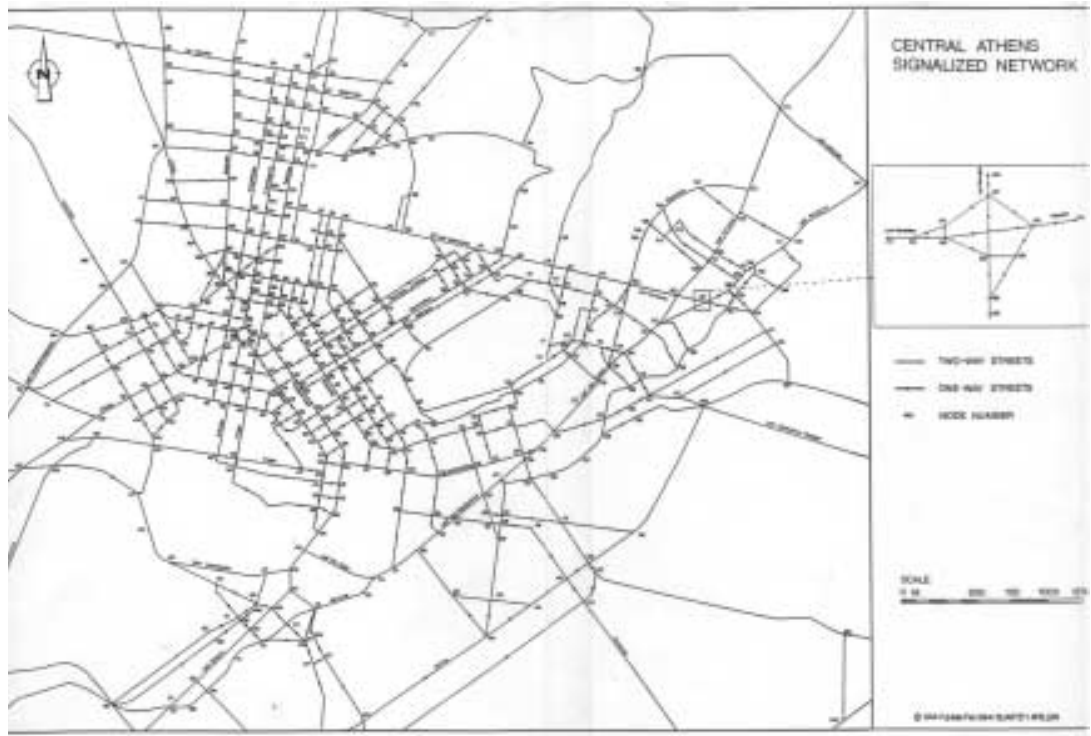
Figure 1. SATURN simulations network (Athens,